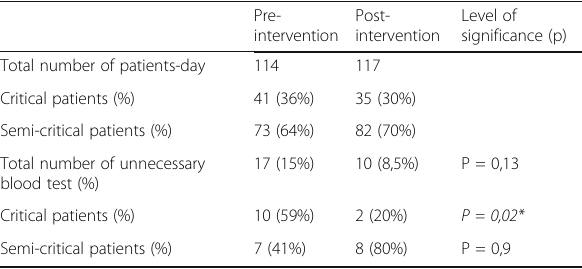
Table 1 (abstract 001530). See text for